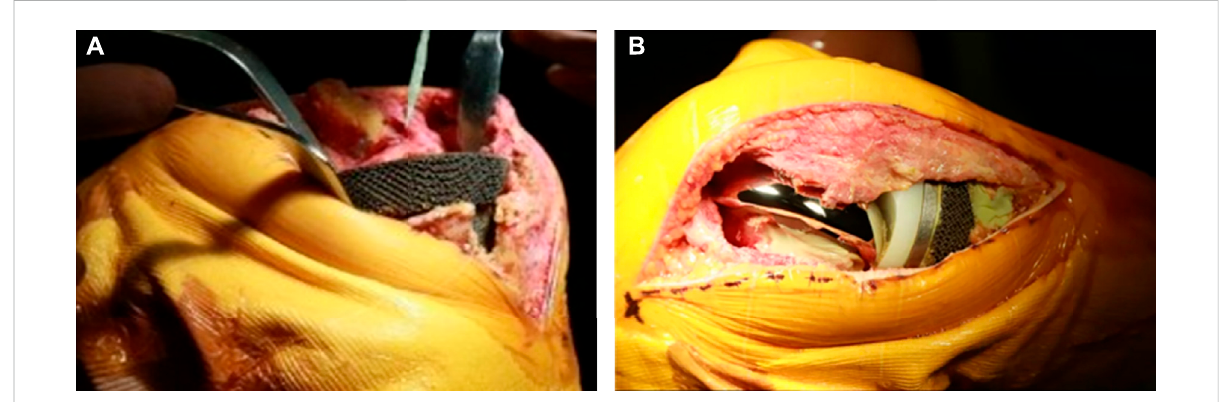
FIGURE 5 Operation of implanting 3D-printed tantalum prosthesis and the TKA revision surgery. (A) After trimming the tibial bone defect, the tantalum prosthesis was implanted into the tibia. (B) Subsequently, commercial components used in TKA revision were implanted into the knee.